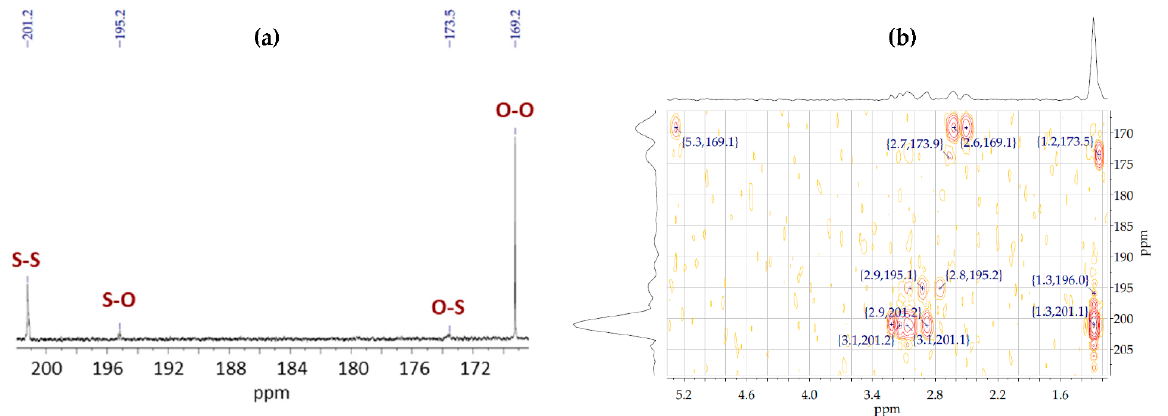
Figure 5. ( a ) 13 C NMR of Sample 5 (3M2MP 54.8 mol%) showing combination peaks; ( b ) 1 H- 13 C HMBC of Sample 5.